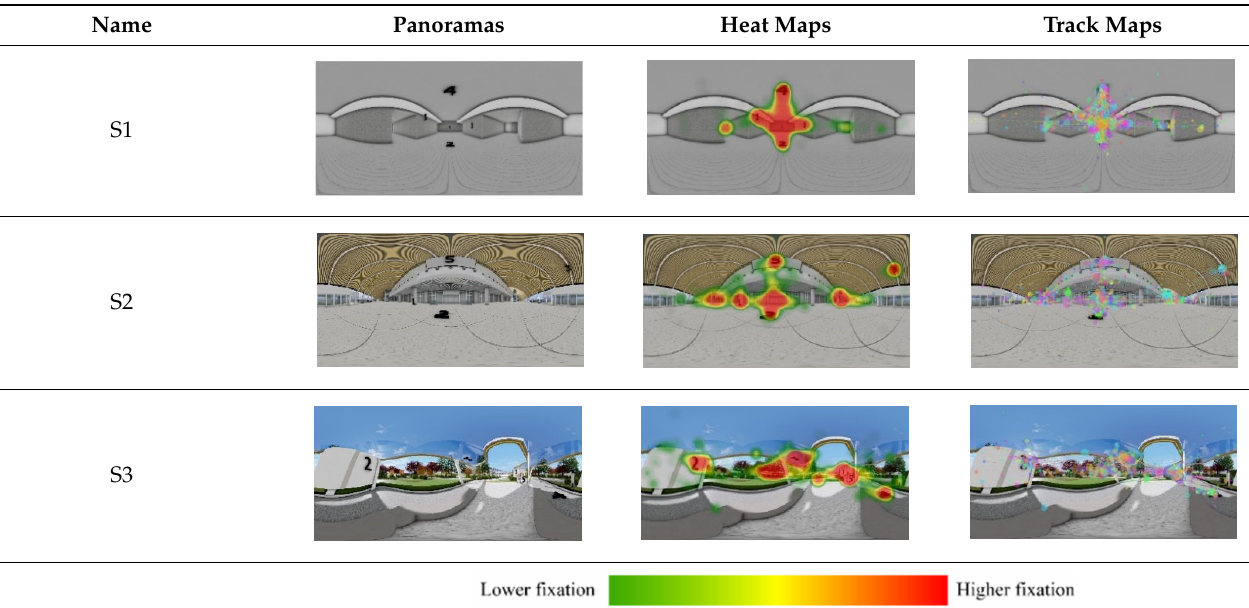
Line and surf- ace combination Surface Outline Line Error First fixationFinal select Appl. Sci. 2022 , 12 , 8520 10 of 17 Figure 5. Comparison of the selection and fixation levels of different symbol types. 3.2. Data from and Results of Experiment 2 The three scenes in Experiment 2 were all from the Taizichen railway station: Scene 1 (S1), the transfer lane inside; Scene 2 (S2), the waiting hall inside; and Scene 3 (S3), the landscape pavilion outside. The visualization results for the subjects in terms of scene memory are shown in Table 7. The visual range of S1 was more concentrated. The fixation points were mainly distributed in a “+” shape, with the center of the picture serving as the midpoint. The visual range of S2 was more dispersed than that of S1. The distribution of viewpoints in the horizontal direction was greater than in the vertical direction. The visual